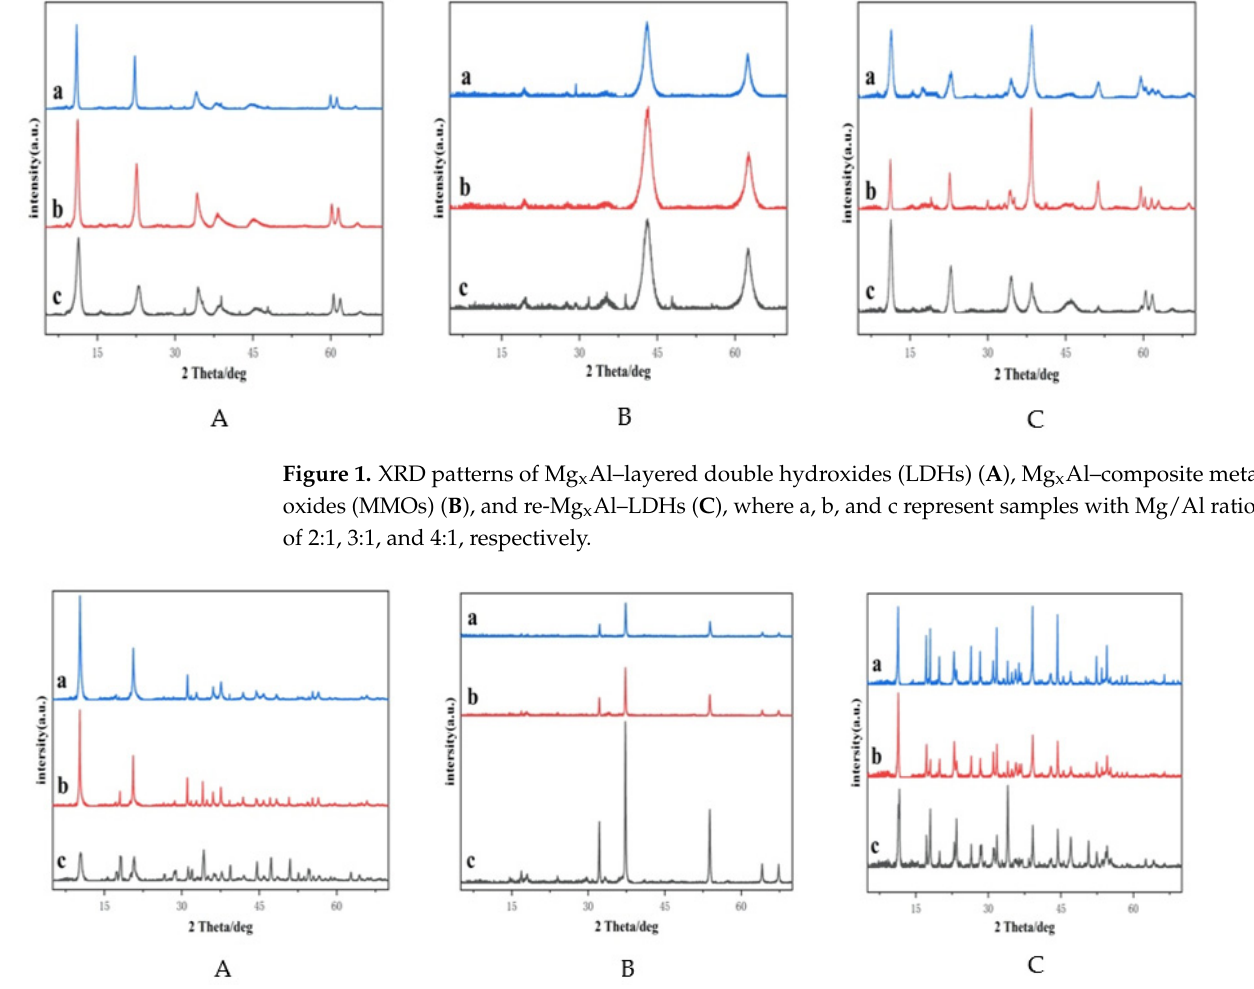
Figure 2. XRD patterns of Ca x Al–LDHs ( A ), Ca x Al–MMOs ( B ), and re-Ca x Al–LDHs ( C ), where a, b, and c represent samples with Ca/Al ratios of 2:1, 3:1, and 4:1, respectively.